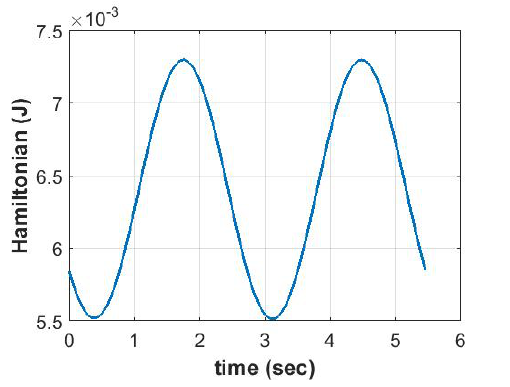
Figure 4. The change in the Hamiltonian over time for Case Study 1.